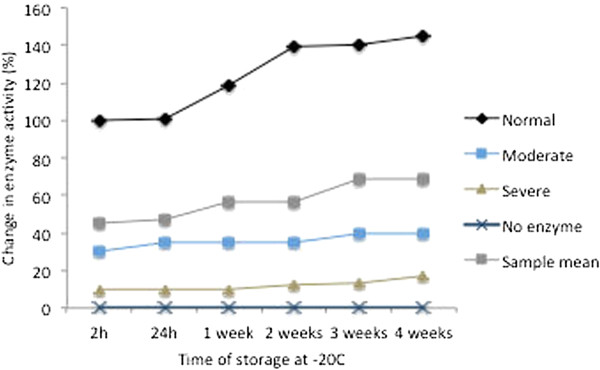
Temperature effects on storage of developed assays. G6PD activity was measured by the WST8/1-methoxy PMS test on fresh samples. The developed assay was then stored at −20°C for 24 h, and 1–4 weeks.